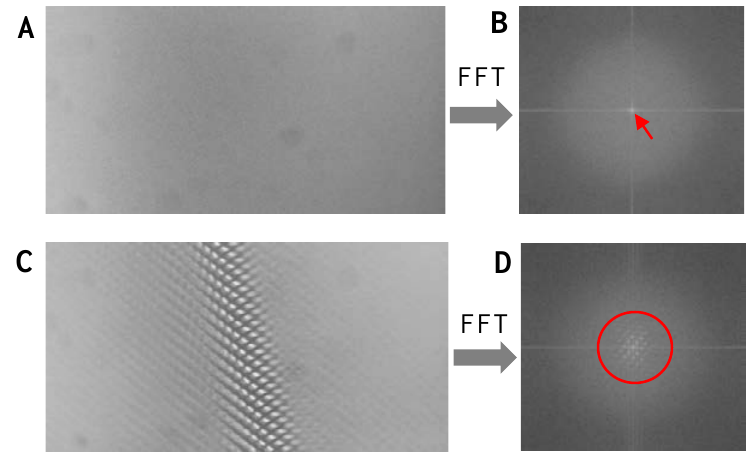
Figure 9. The frequency characteristic of the captured image. ( A,C ) Captured image in spatial domain without and with the presence of cellphone. ( B,D ) Captured image in frequency domain without and with the presence of cellphone.